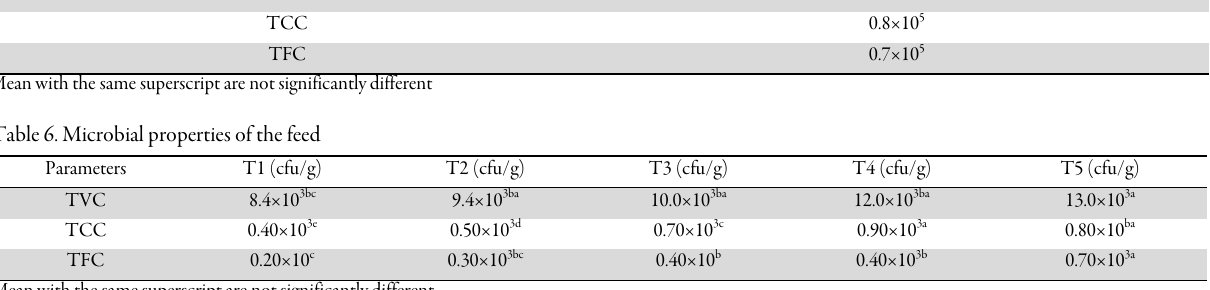
Mean with the same superscript are not significantly